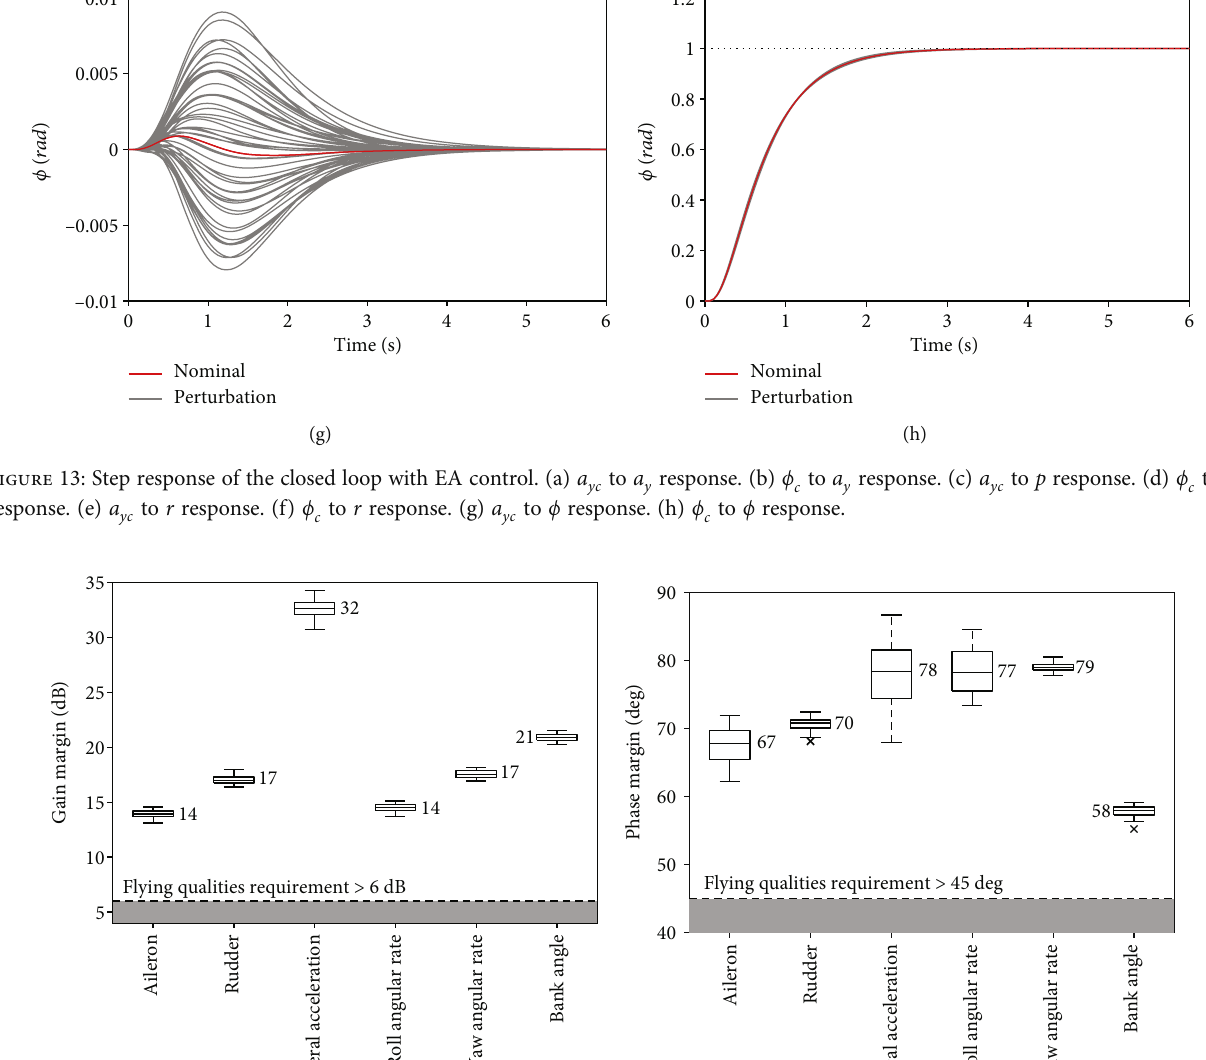
to p response. (d) ϕ yc